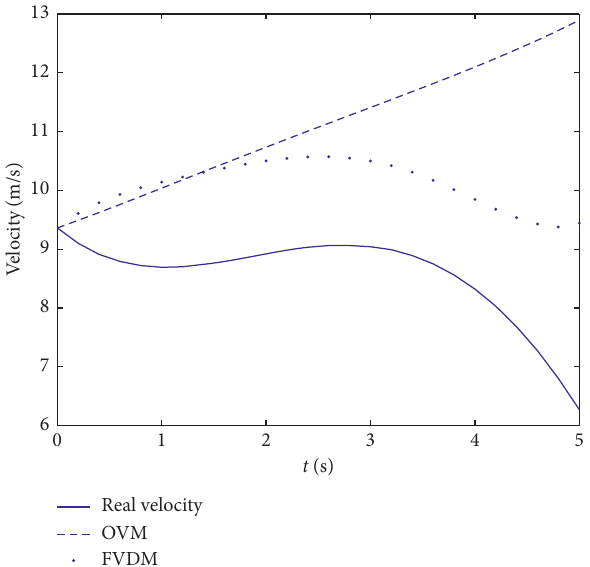
Figure 3: Comparison between simulation curves of classic car- following models and the curve of real